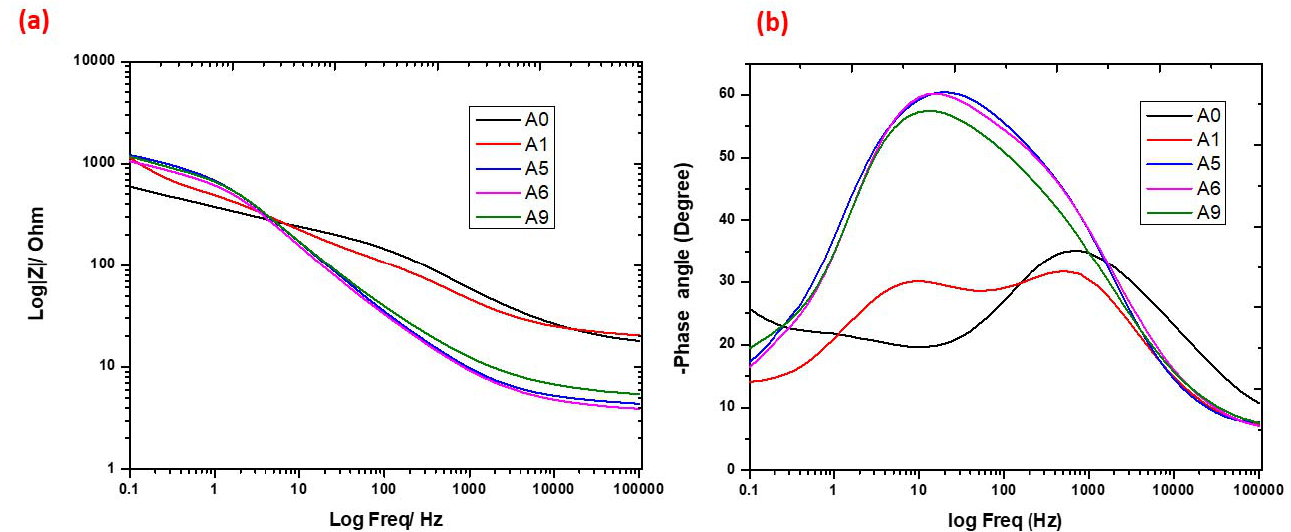
Figure 7. ( a ) Bode profiles, ( b ) Bode phase profiles of samples in 3.5% NaCl for 72 h.